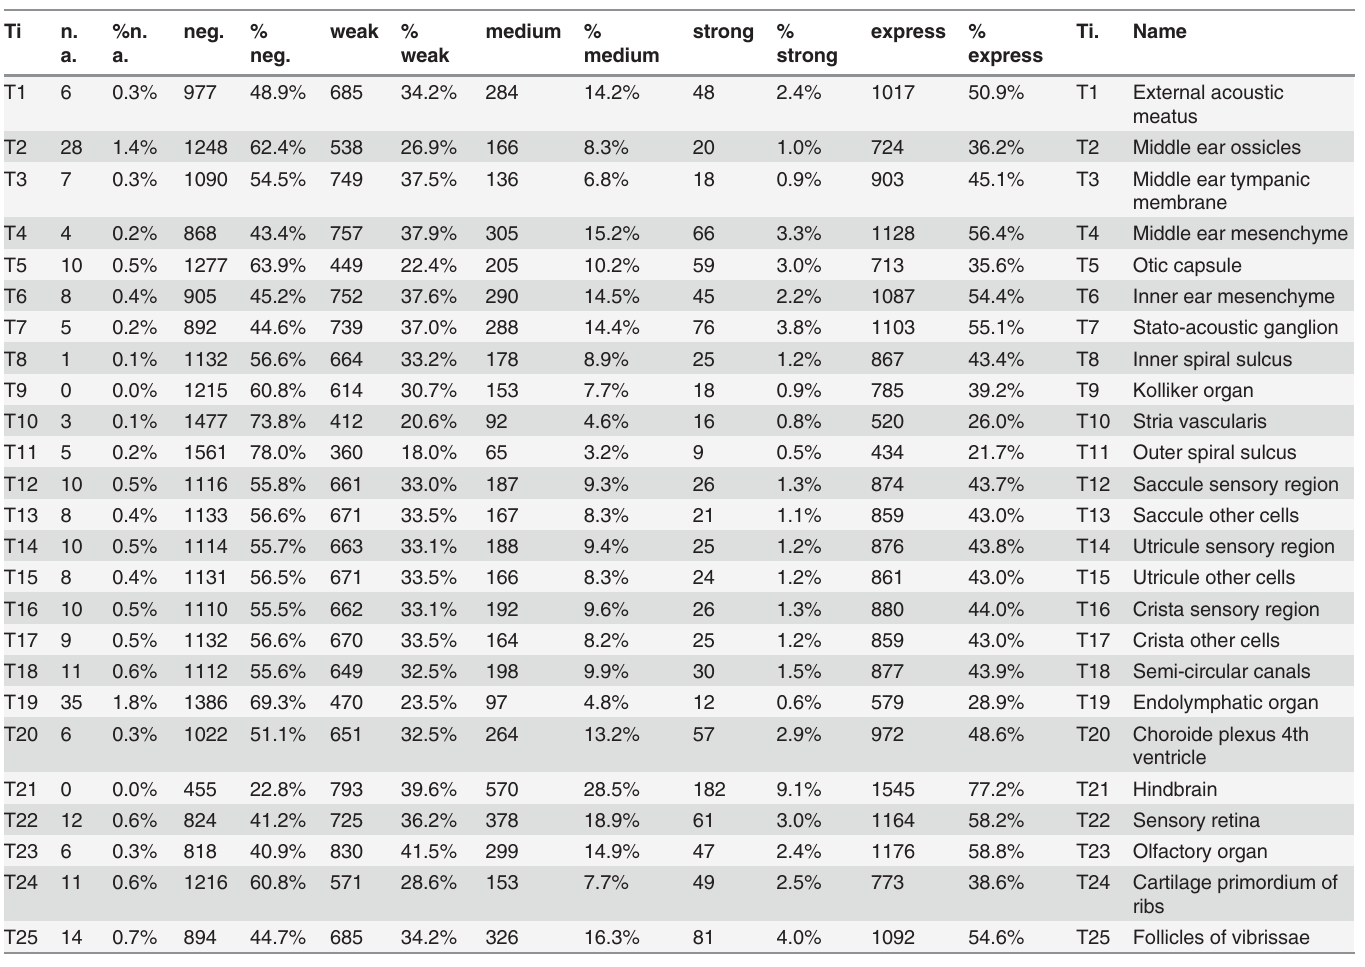
Table 1. Gene expression in the 25